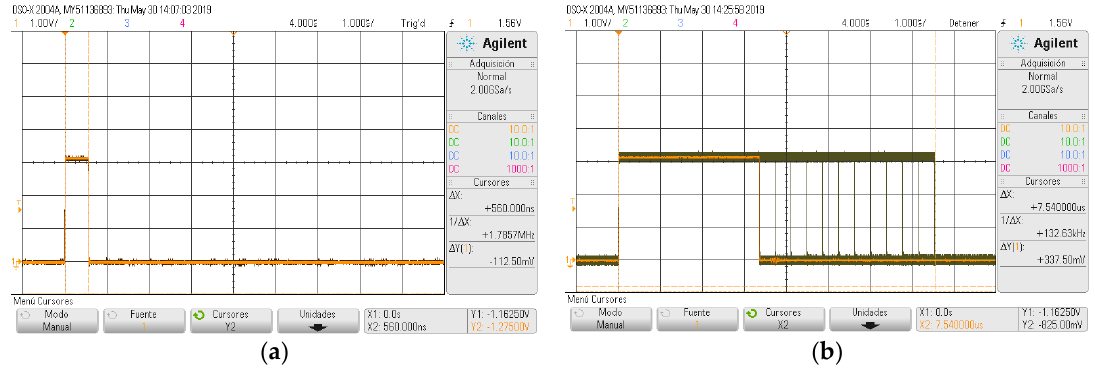
Figure 11. Execution time of the algorithm ( a ) lookup table implementation. ( b ) equations implemented and solved in real time.